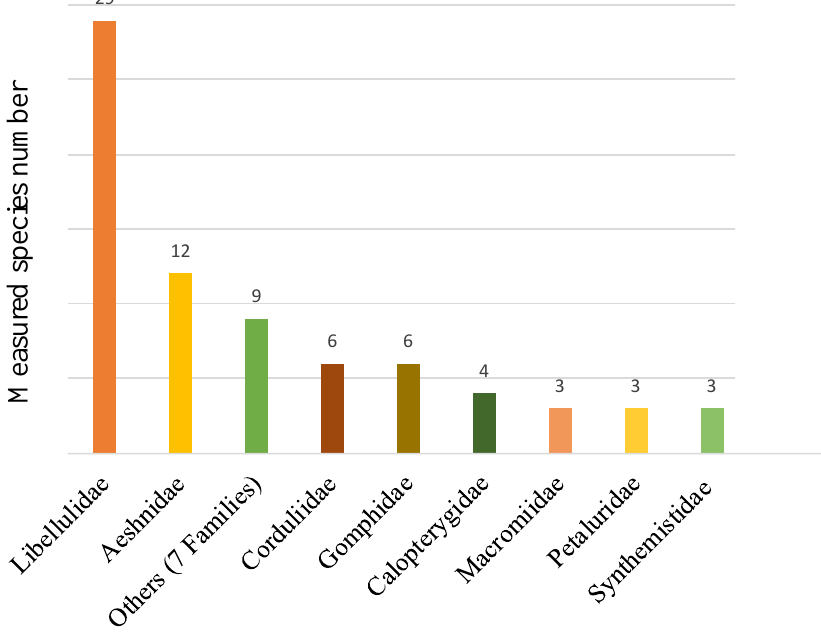
Figure 2. Number of each genus of Odonata, according to their species.